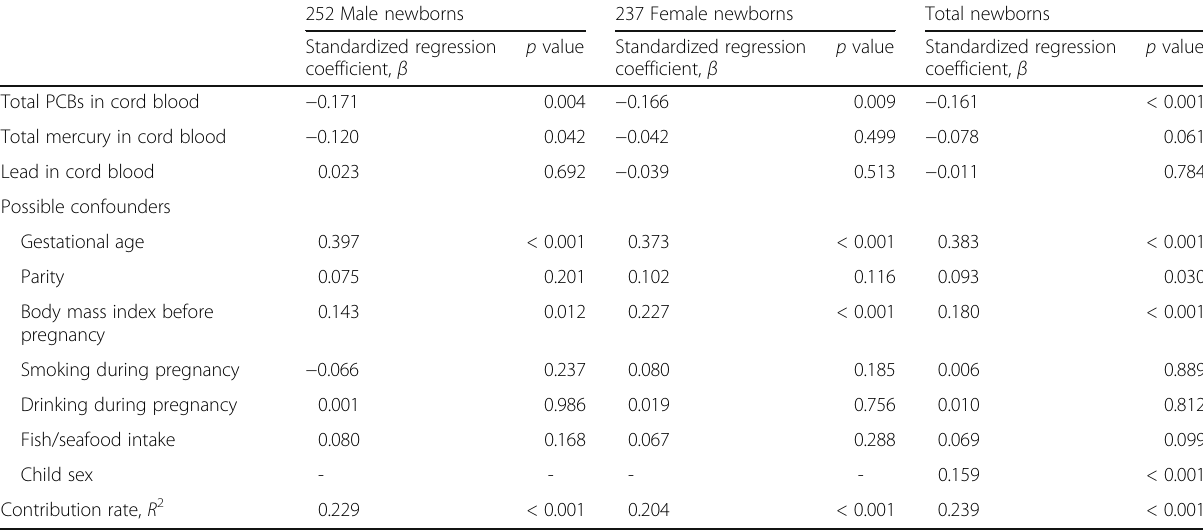
Table 3 Relations of prenatal biomarkers and confounders to birth weight: results of multiple regression analysis